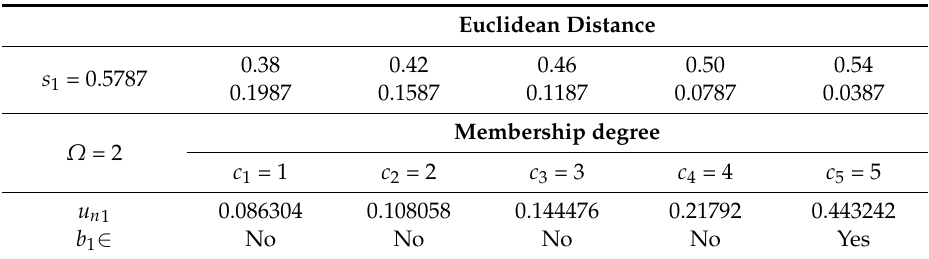
Table 4. Membership degree of the first block to the initial cluster center vector.